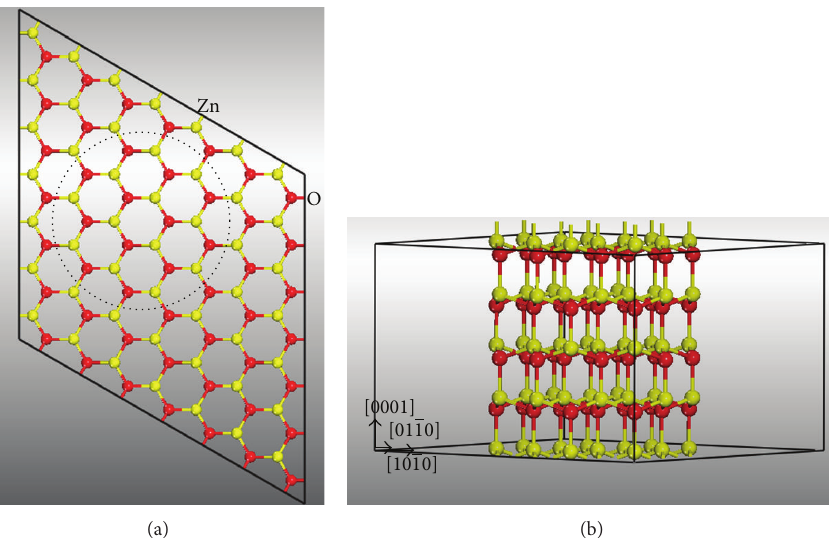
Figure 1: (a) Top view of a 7 × 7 × 2 ZnO supercell with wurtzite structure, (b) Zn 48 O 48 supercell which yields a nanowire along [0001] direction.